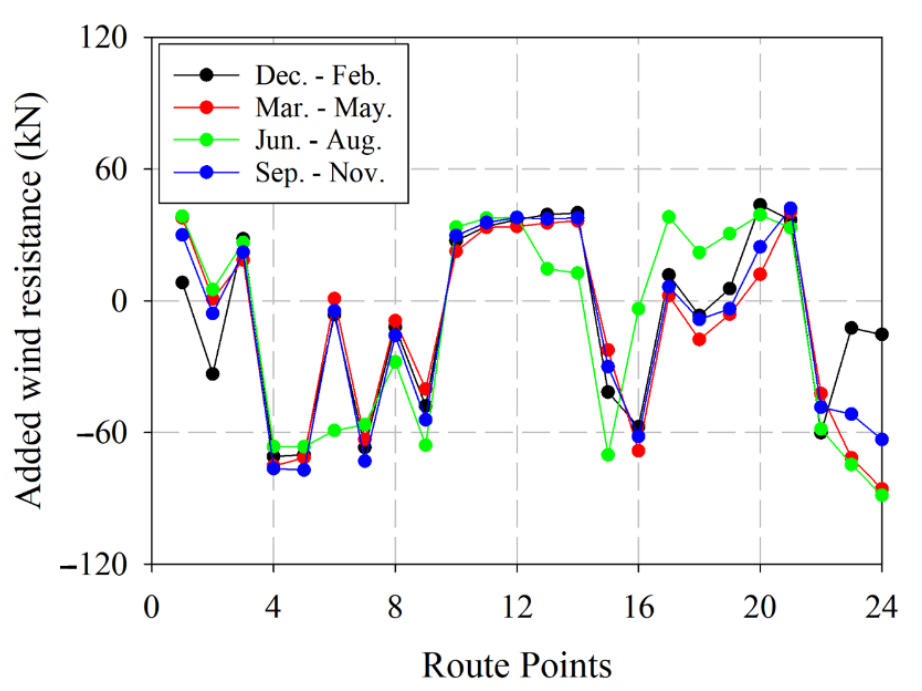
Figure 13. Added wind resistance per each route point and per season considered. Source: Own elaboration.